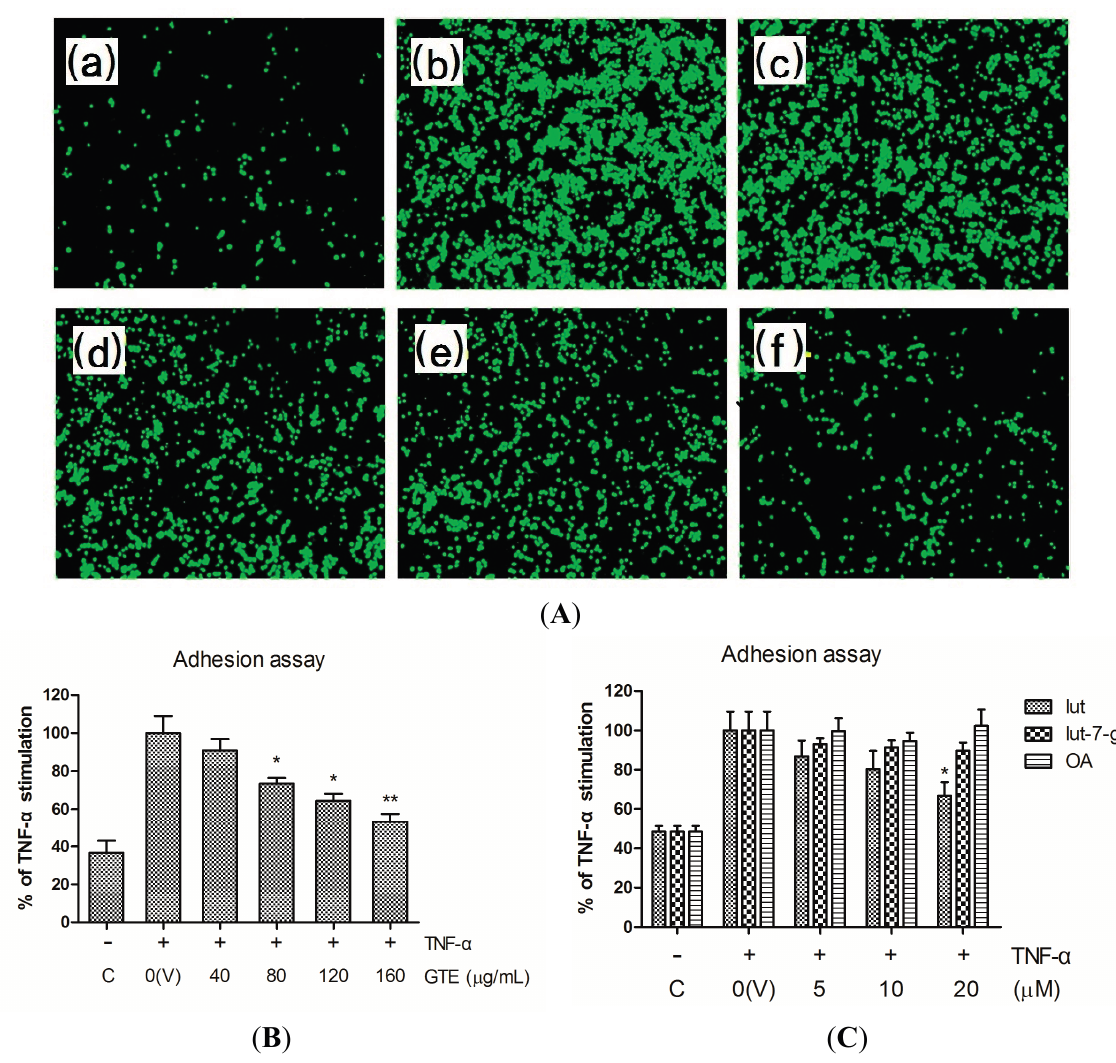
dose-dependent manner. Lut and lut-7-g induced significant dose-dependent inhibition of ICAM-1 expression, especially at doses higher than 5 μ M. Furthermore, the expression of VCAM-1 was markedly inhibited by lut and lut-7-g (above 10 μ M). In contrast, the triterpenoid OA failed to inhibit the expression of ICAM-1 and VCAM-1.